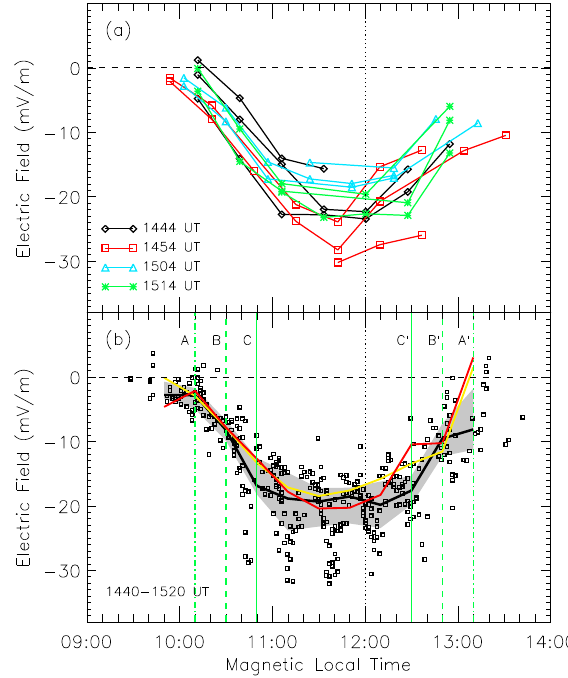
Fig. 9. The spatial variation (with MLT) of the reconnection elec- tric field along the ionospheric projection of the X-line. ( a ) The spatial variation of the reconnection electric field for four selected 2-min intervals (times as shown). ( b ) All the reconnection electric field values measured in the interval 14:40–15:20 UT (square sym- bols) using the velocity vectors at 81.5 ◦ latitude. The bold black line represents the variation of the median electric field value when the estimates are organised into 20-min bins. The grey-shaded re- gion represents the upper and lower quartiles of this electric field distribution. The bold yellow line represents the median of the elec- tric field values that result when using the vectors located at 80.5 ◦ latitude. The bold red line represents the median of the electric field values that result when using the vectors located at 82.5 ◦ latitude. The vertical solid, dashed, and dot-dashed green lines mark the ap- proximate extent of the X-line when assuming that it is best de- scribed by the extent of the maximum electric field, the half-width of the electric field distribution and the minimum electric field, re-